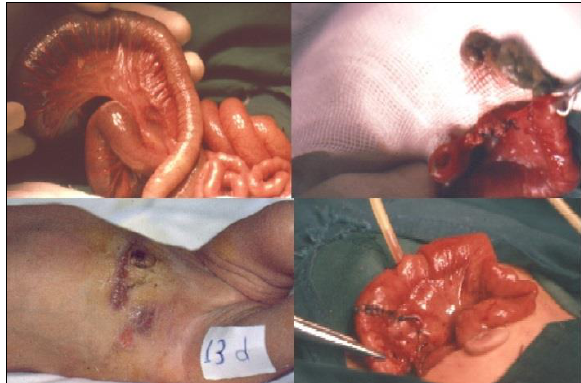
Figure 2: T-tube enterostomy technique in cases of Meconium ileus.